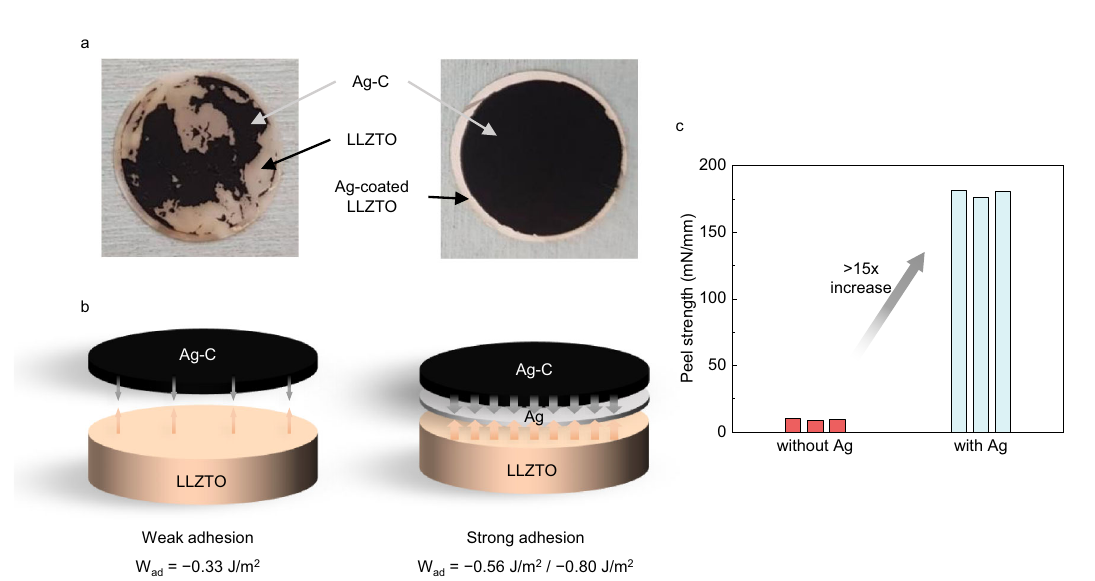
role of Ag as a binding agent. c Measured peel strength between LLZTO and Ag-C interlayer. Note that 3 bars in the graph refer to three different measurements for the same